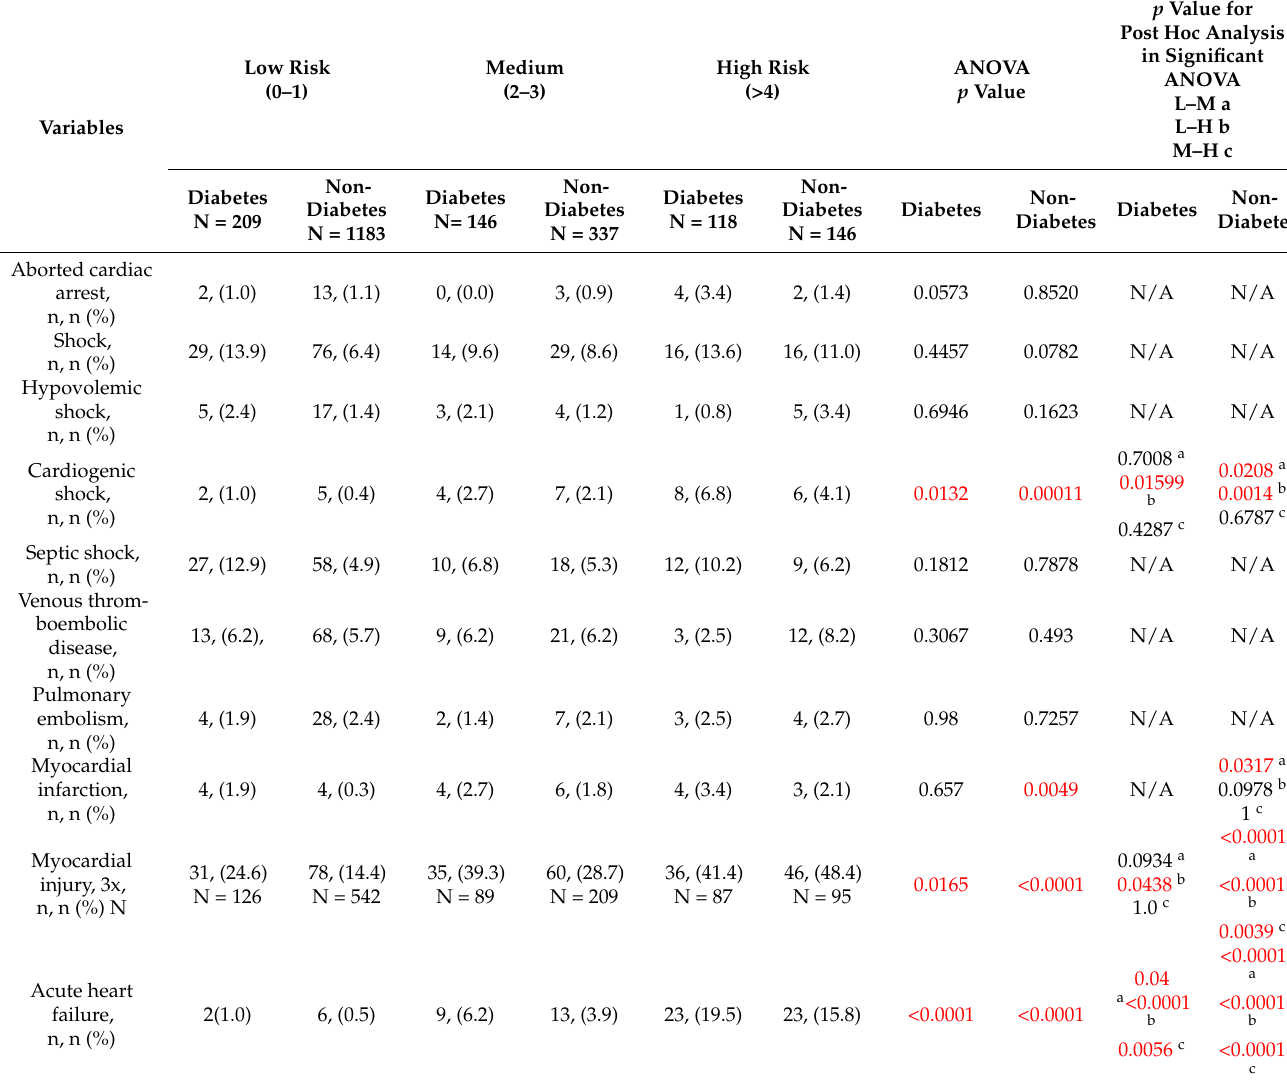
Table 7. Clinical non-fatal events and hospitalization outcomes in the C 2 HEST risk strata in the diabetic and non-diabetic